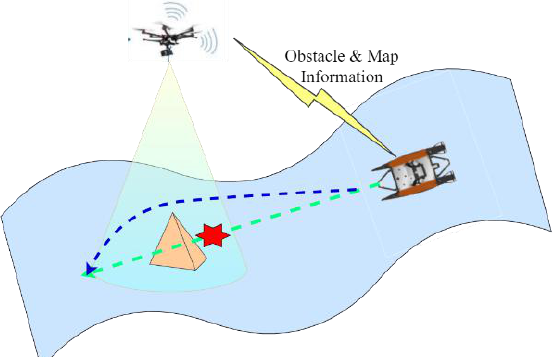
Figure 1. An illustration of the USV-UAV cooperative system, where the UAV provides wide obstacles and map information to guide the USV to generate an obstacle avoidance